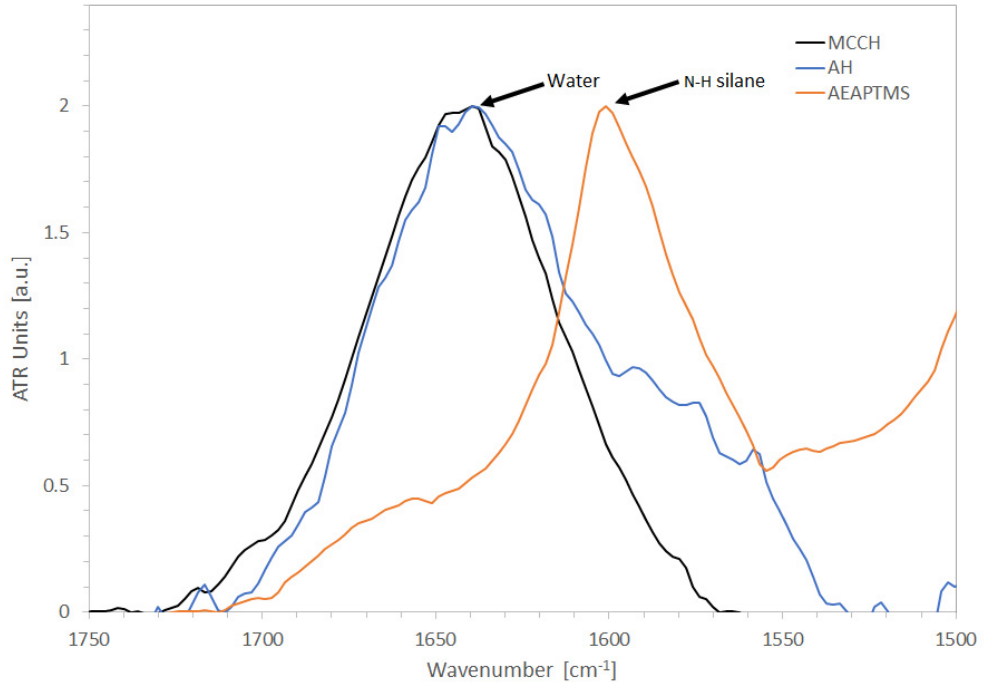
Fig. 3 FT-IR spectra of MCCH, AH and